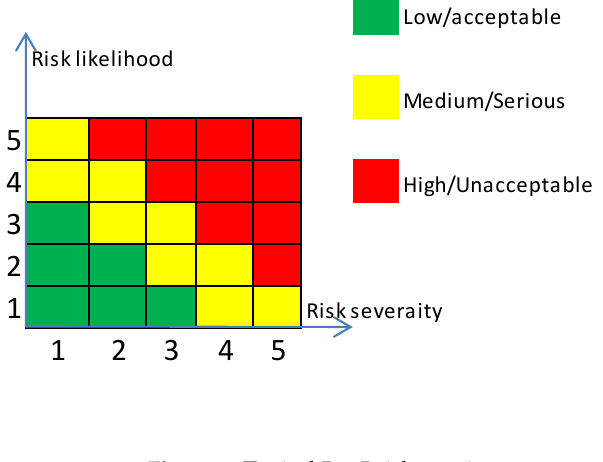
Figure 2. Typical 5 × 5 risk